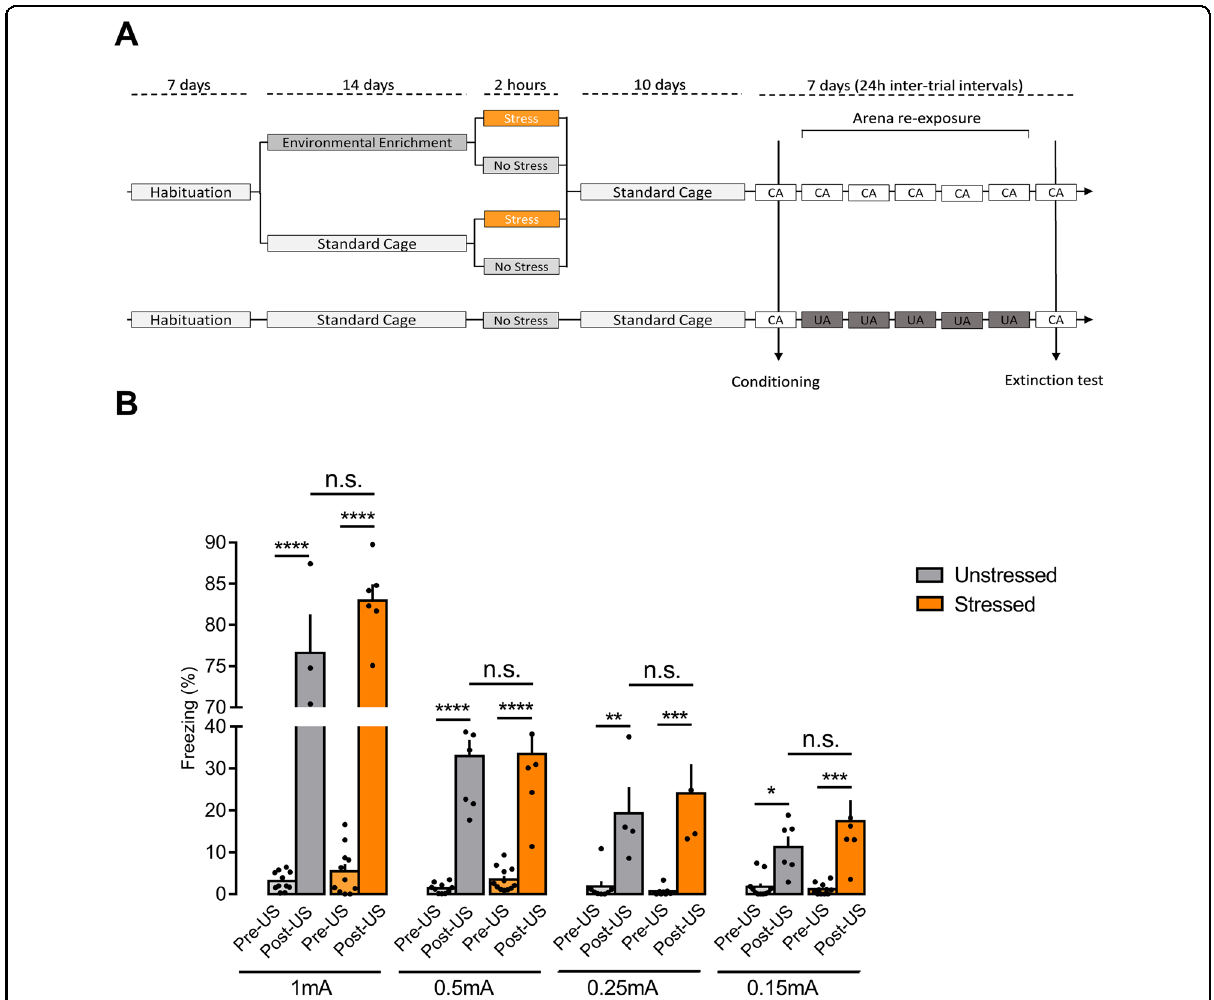
Fig. 1 Experimental design and the stress in fl uence on the acquisition of contextual fear memory. Schematic timeline of the experimental procedure ( A ): CA conditioning arena, UA unpaired arena. Behavioral freezing response 24 h after (Post-US) conditioning session (Pre-US) with 1, 0.5, 0.25, and 0.15 mA footshock ( B ). Animals conditioned 10 days after 2 h of restraint stress did not show higher freezing levels comparing to unstressed animals regardless of the intensity of the US. Results are represented as mean ± SEM ( n = 5 animals per group, 0.25 mA; n = 6 per group, 1 and 0.15 mA; n = 8 per group, 0.5 mA). Two-way ANOVA followed by Tukey ’ s multiple comparisons test. Signi fi cance differences between groups are indicated as * p < 0.05, ** p < 0.01, *** p < 0.001, and **** p < 0.0001; n.s. nonsigni fi